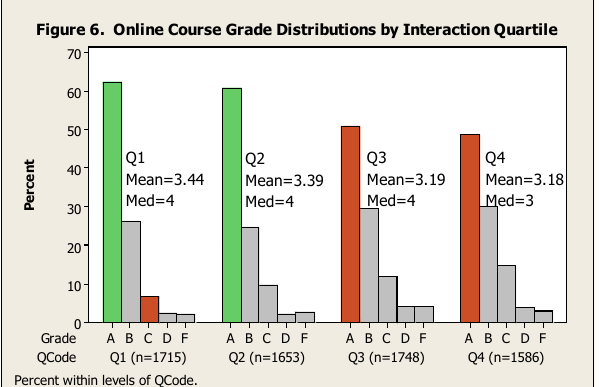
Figure 6 . Online course grade distributions by interaction